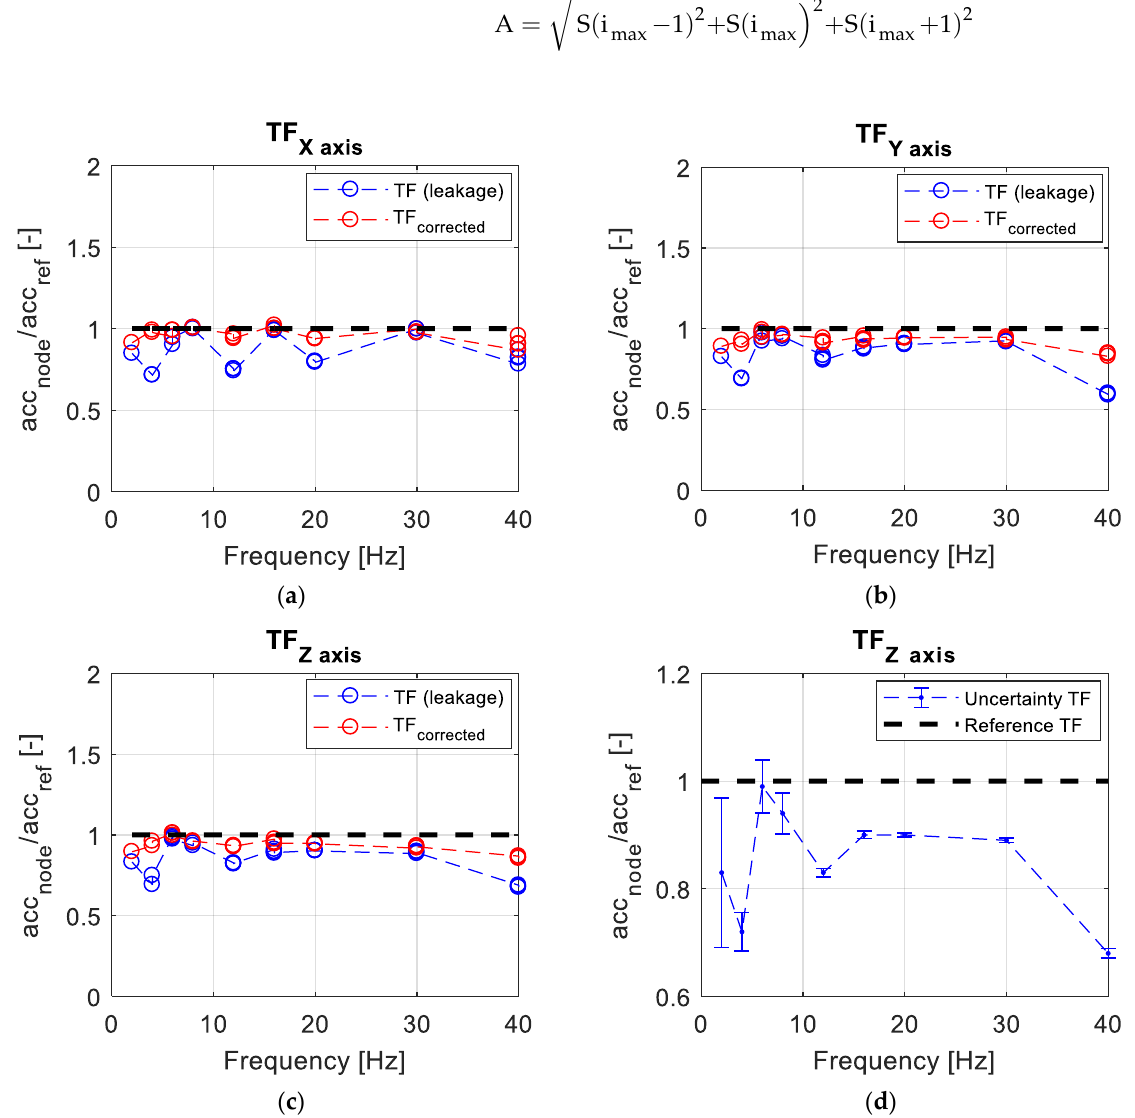
Figure 6. Shaker test results: ( a ) X axis transfer function; ( b ) Y axis transfer function; ( c ) Z axis transfer function; and ( d ) uncertainty estimated by means of error bands for each considered frequency [1] © 2020 IEEE.